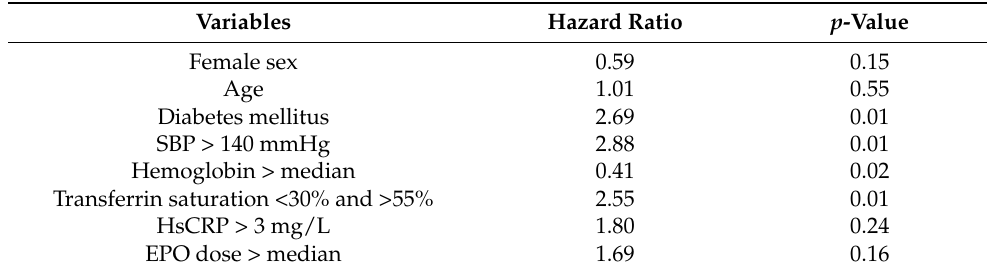
Table 6. Risk factors associated with cardiovascular mortality in the long term (78 months): univariate Cox regression